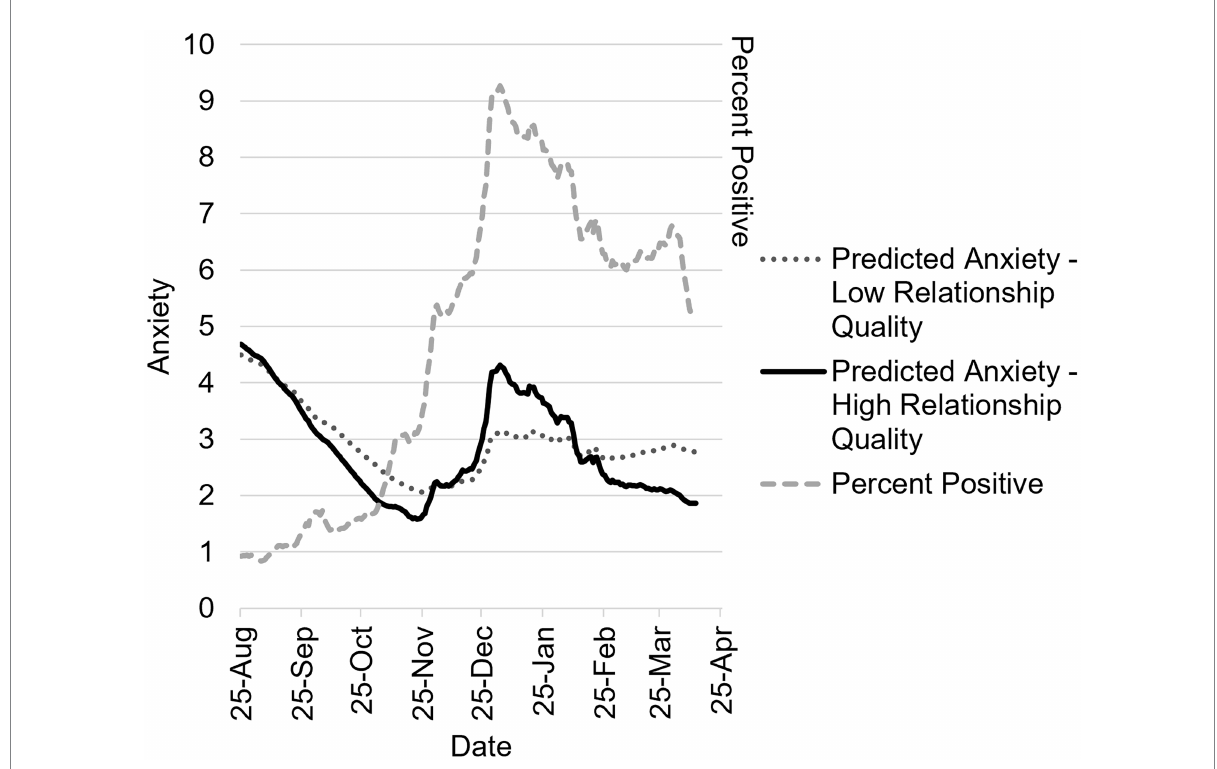
FIGURE 3 Three-way interaction model predicting daily anxiety between August 2020–April 2021 as a function of COVID-19 percent positivity testing rate, season, and relationship quality. Predicted daily anxiety in individuals with low-quality ( − 1 SD ) and high-quality (45; maximum score, since +1 SD was slightly outside the range of the scale) relationships as a function of daily percent positive testing rate in NYC and season. Anxiety scores can range from 1 to 9, and percent positive can range from 0 to 100, but the range of percent positive was 0.84 to 9.14 during the observation period. The jagged shape of the graph comes from modeling the effect of actual reported citywide seven-day percent positivity